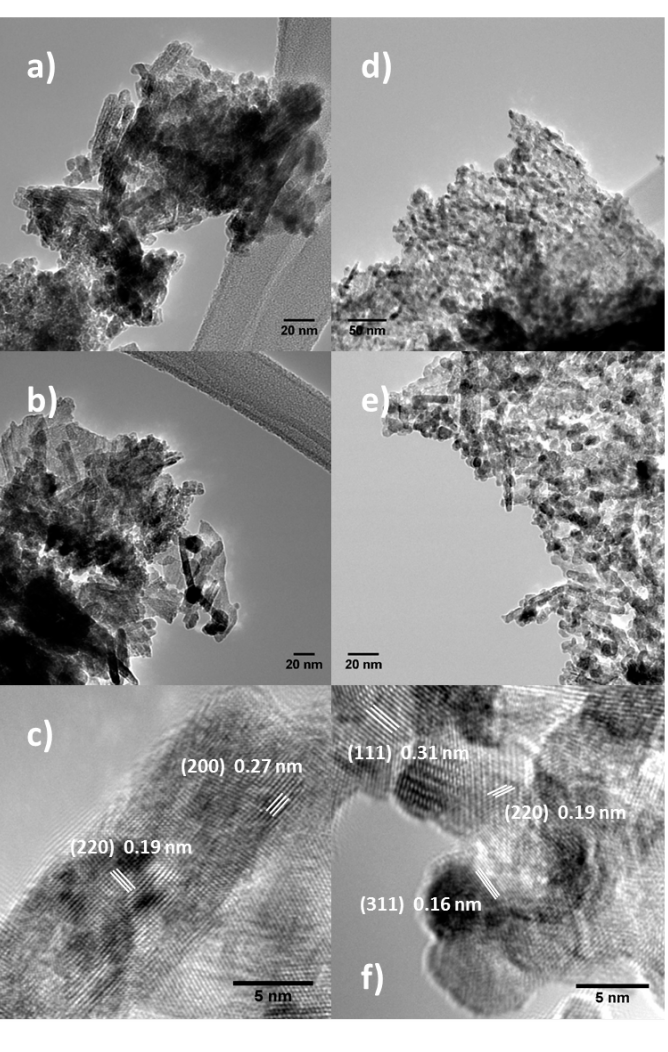
Figure 3. TEM image of Space CeO 2 sample: 1 M ( a – c ) and 3 M ( d – f ).